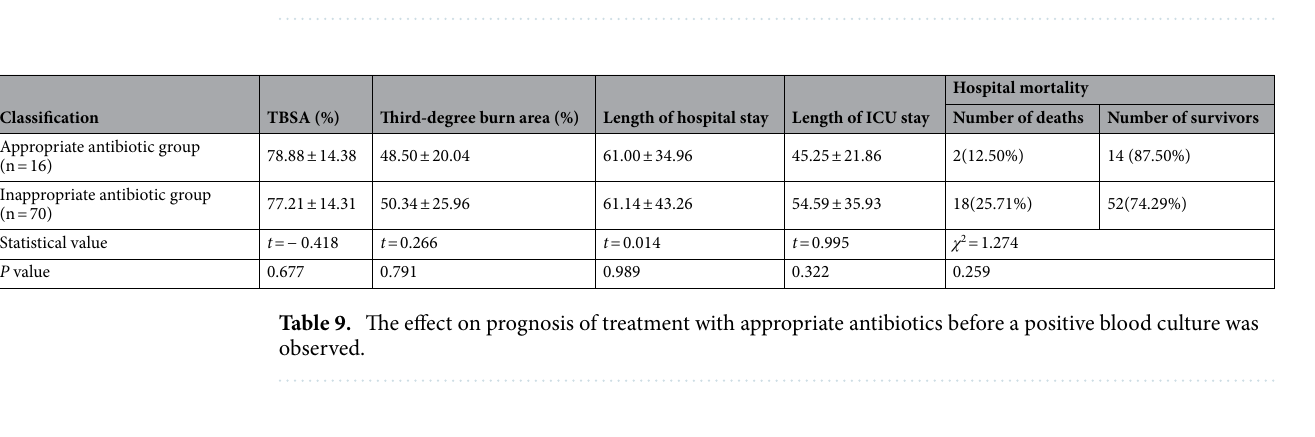
Table 8. The effect on prognosis of initial treatment with appropriate antibiotics within 24 h after admission among patients with positive blood cultures.